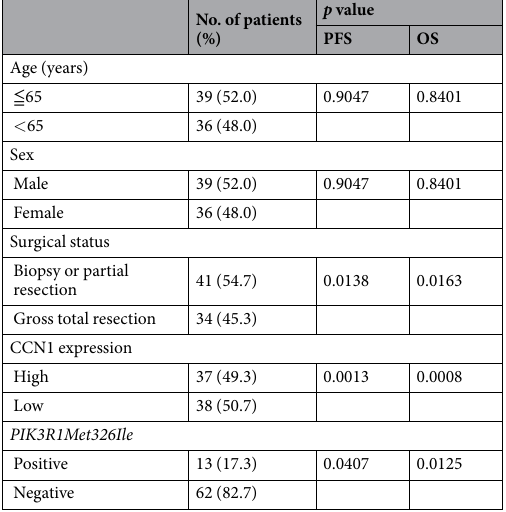
Table 4. Univariate analysis of prognostic factors for progression-free survival and overall survival in glioblastoma patients. PFS = progression free survival; OS = overall survival.